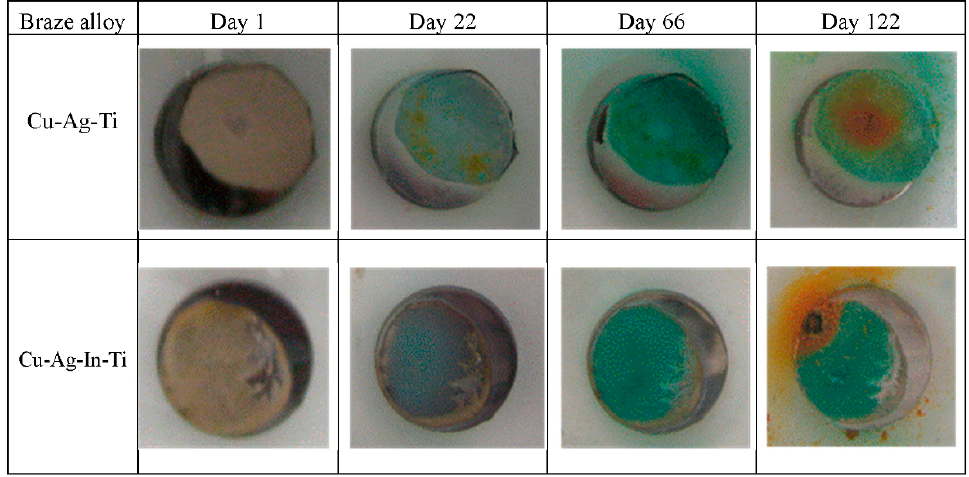
Figure 7. Time lapse photographs of corrosion propagation during long term exposure testing in 0.6 M NaCl. Cu ‐ Ag ‐ Ti ( top ) and Cu ‐ Ag ‐ In ‐ Ti ( bottom ) braze alloy foil disks were used to coat ~80% of the exposed face area on 316L stainless steel samples. The stainless steel disk diameter was 16 mm for both